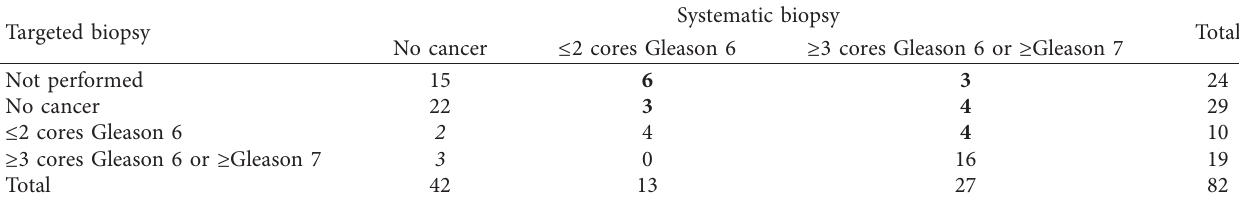
Table 3: Whole group pathology outcomes of systematic biopsy and targeted